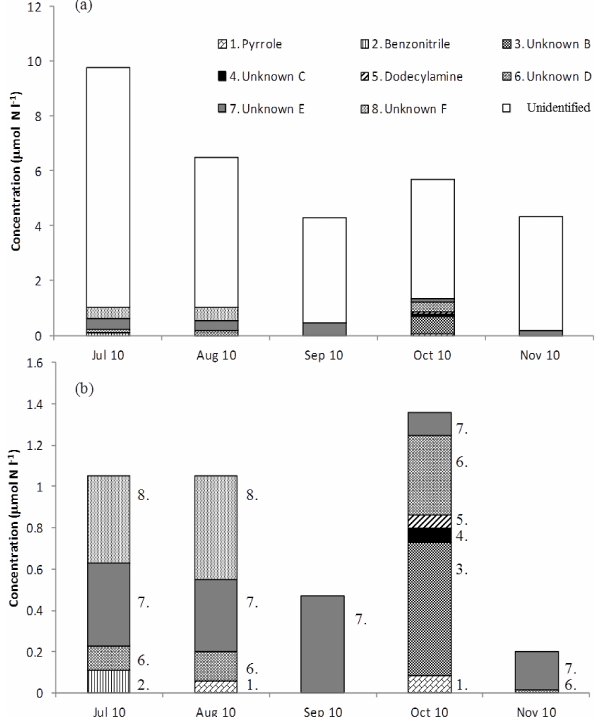
Figure 5. Mean monthly concentrations of the individual DON compounds found in precipitation water. Panel (a) includes the DON fraction identified from the Antek (white bar), whilst (b) ex- cludes the unidentified fraction, so that the speciation achieved by GC × GC-NCD is more clearly seen.